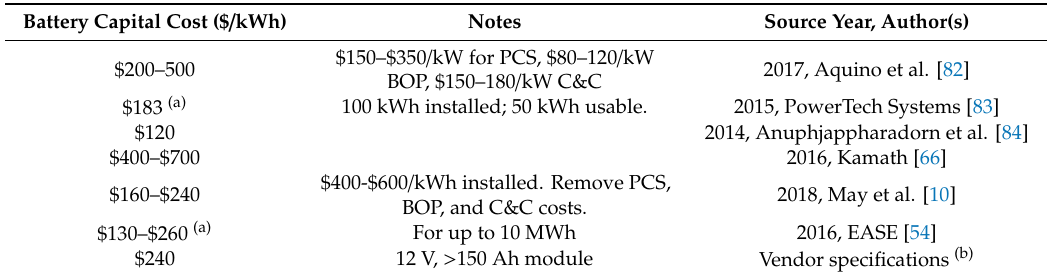
Table 15. Capital cost estimates—lead acid technology.